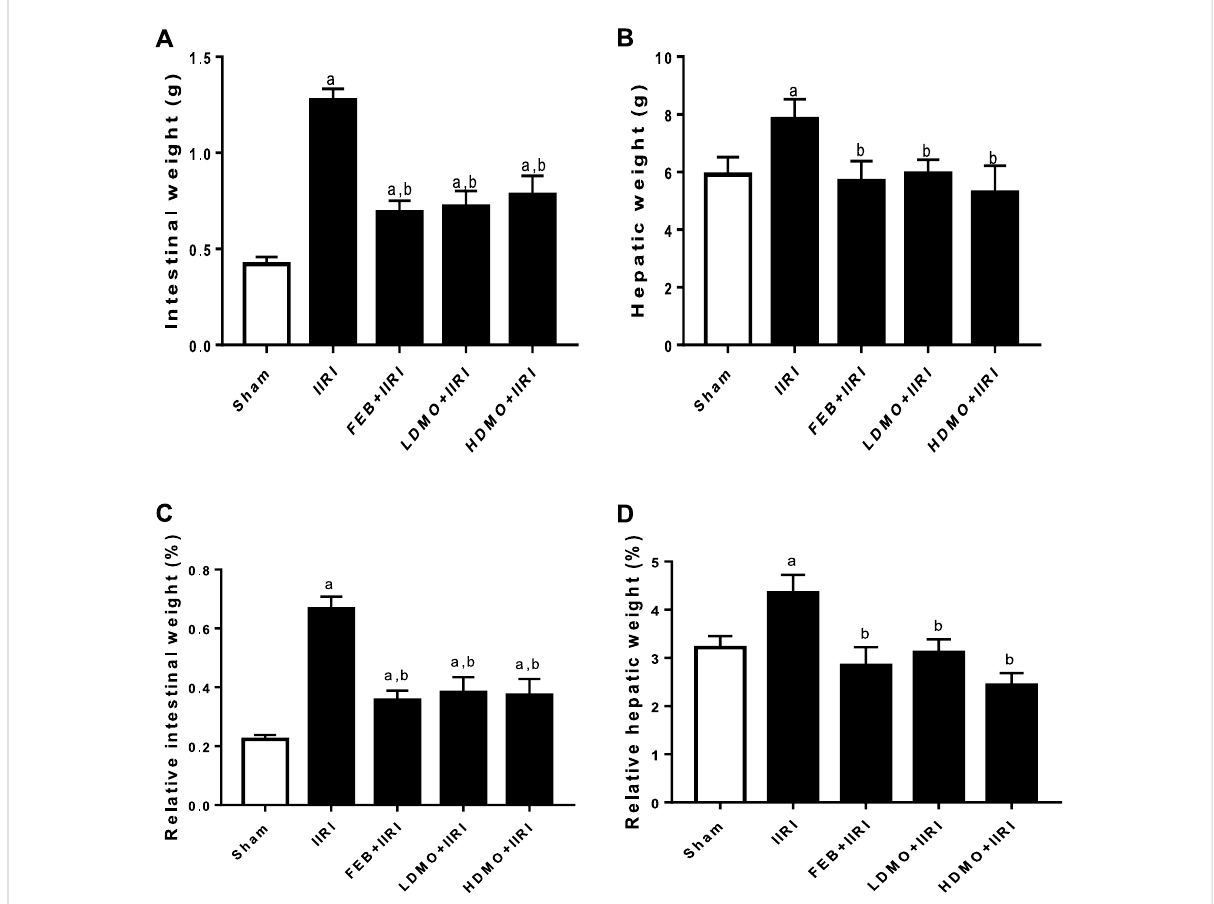
FIGURE 1 Effect of intestinal ischaemia/reperfusion (I/R) and methanolic Moringa oleifera leaf extract on intestinal weight (A) , hepatic weight (B) , relative intestinal weight (C) , and relative hepatic weight (D) . IIRI: Intestinal ischaemia/reperfusion injury, FEB: febuxostat, LDMO: low dose Moringa oleifera, HDMO: high dose Moringa oleifera, a p < 0.05 versus sham, b p < 0.05 versus IIRI. Data were analyzed by one-way ANOVA followed by Tukey ’ s post hoc test. Values are expressed as mean ± SD of 10 rats per